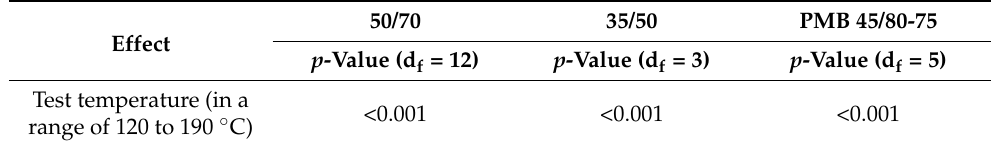
Table 2. Analysis of variance for dynamic viscosity of the tested bitumen binders, α = 0.05, the effect of temperature.